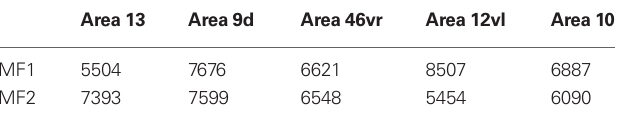
Table 3 | estimates of the total number of spines in the basal dendritic tree of the “average” layer iii pyramidal cell in prefrontal areas of the macaque monkey.